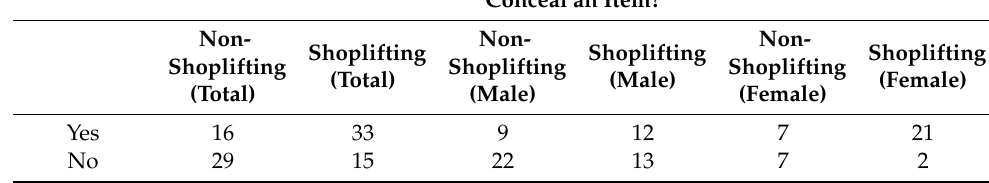
Table 4. Frequency of shoplifters wearing baggy